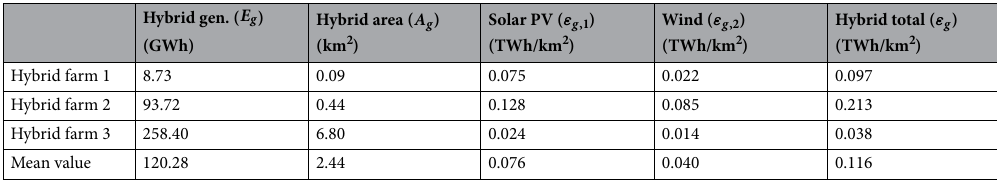
Table 14. Occupied areas and mean power densities of three hybrid renewable farms ( n = 3 ) combining solar PV and wind technologies, including 1 in the Netherlands (Haringvliet Zuid), 1 in the UK (Parc Cynog), and 1 in Australia (Port Augusta).